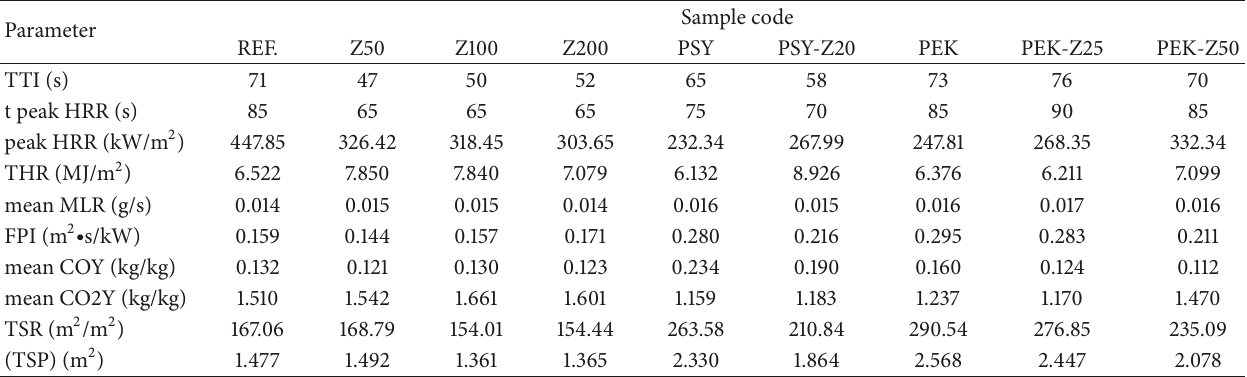
Table 6: Cone calorimeter test results of all